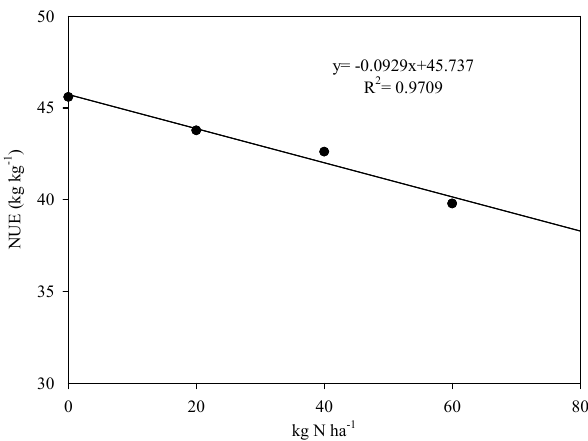
Figure 5. Nitrogen use efficiency (NUE) of barley vs. nitrogen fertilization levels (not fertilized = N0; fertilized with 20 kg N ha − 1 = N20; fertilized with 40 kg N ha − 1 = N40 and fertilized with 60 kg N ha − 1 = N60).